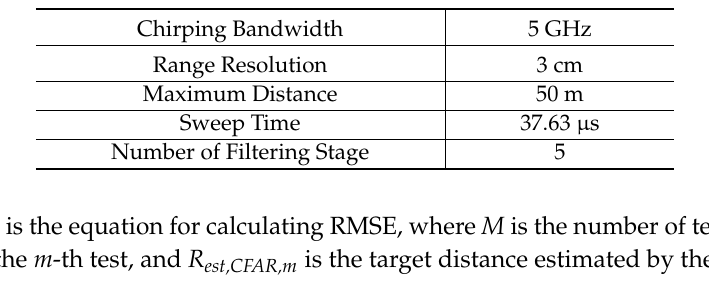
Table 2. Simulation environment in the proposed system.